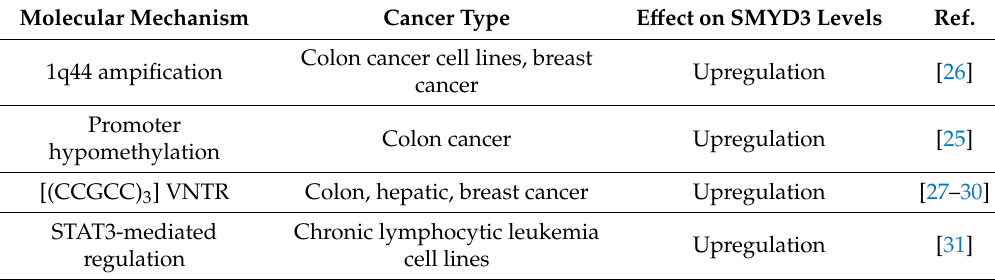
Table 1. Summary of mechanisms regulating SMYD3 levels in